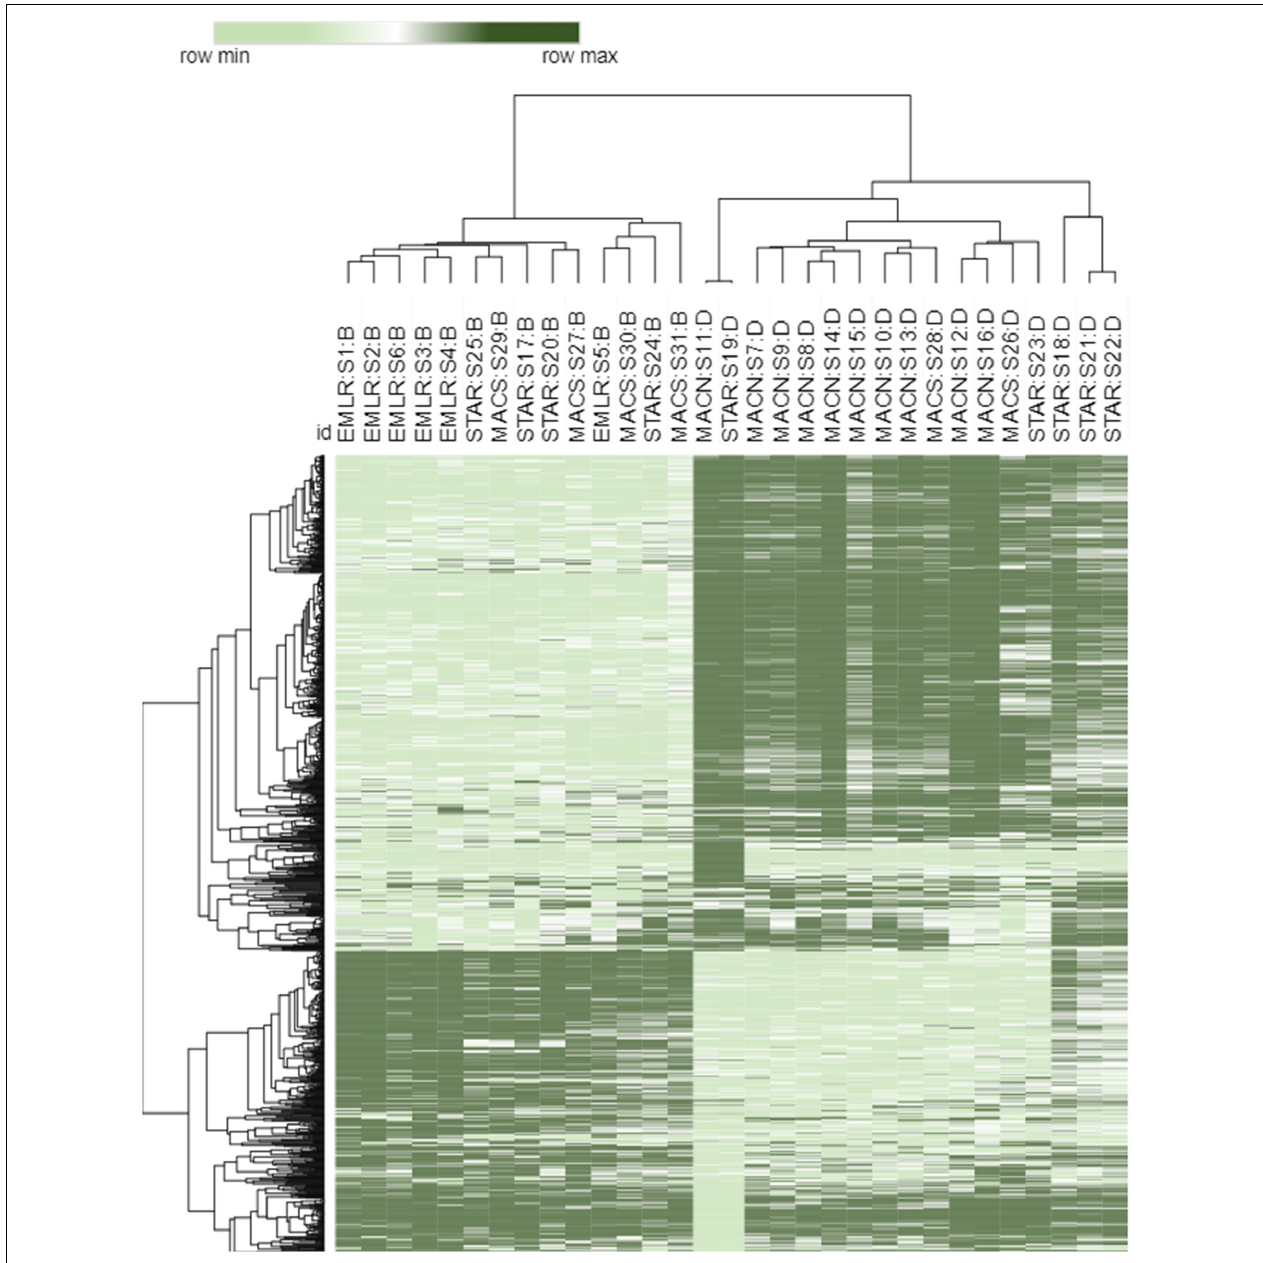
FIGURE 2 | Heat map of top 1,000 transcripts contributing the highest weight to the PC1 axis of the PCA in Figure 3 . Both samples and transcripts were clustered using the k-means complete hierarchical clustering method and a Euclidean distance dissimilarity matrix. The samples are labeled with a study site (MACN, MACS, STAR, EMLR), sample number (S1–S31) and dominant symbiont type (B- Breviolum and D- Durusdinium ).